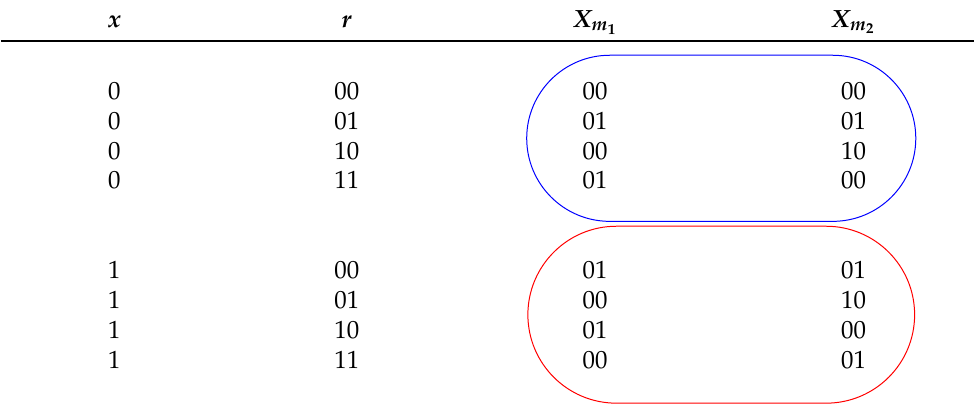
Table 1. Sample residue computation for l =